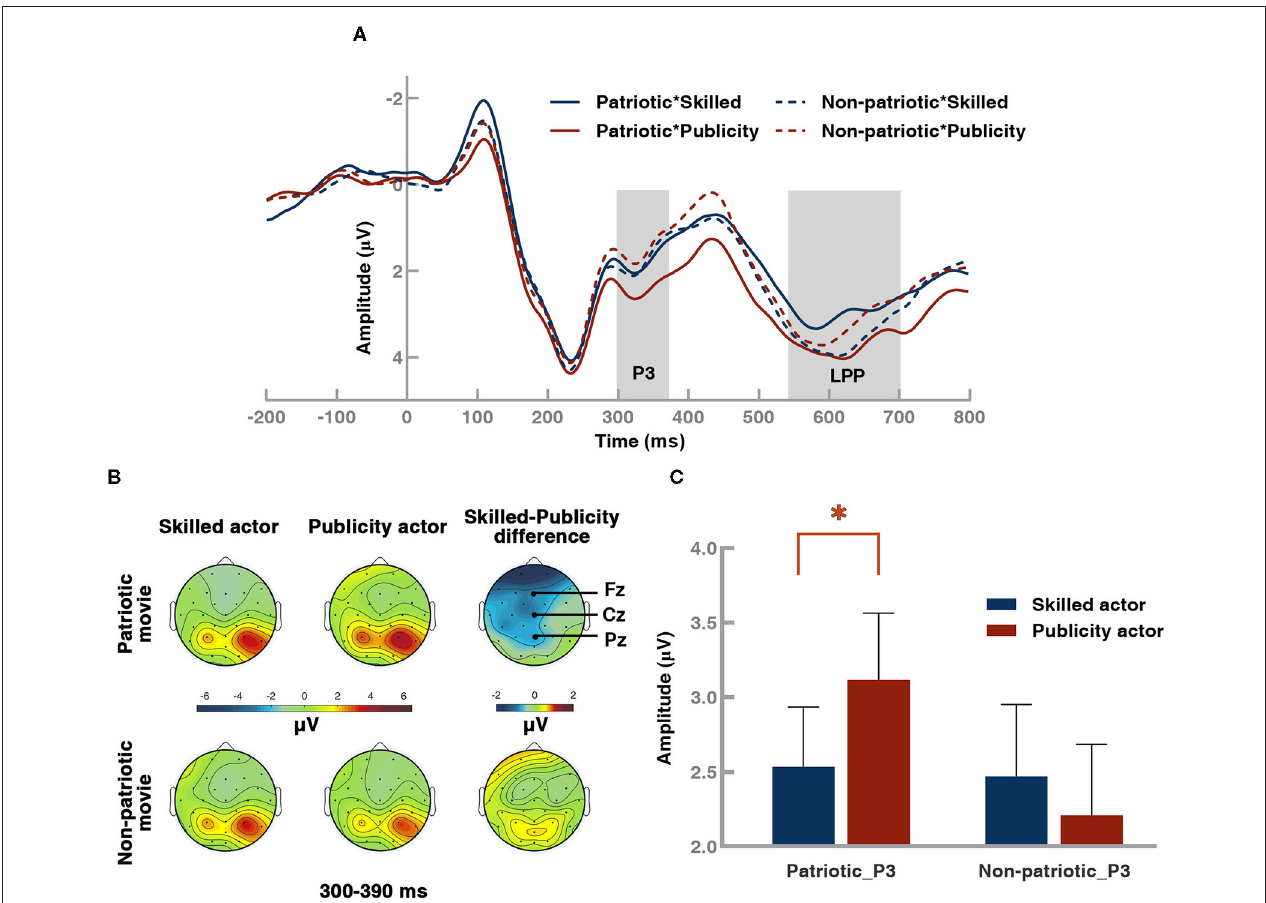
FIGURE 3 | Event-related potential (ERP) waveforms from Pz, topography of grand-averaged P3 waveforms from Pz, and P3 results. (A) Grand-averaged ERP under four conditions: 2 movie types (patriotic: solid line, non-patriotic: dotted line) × 2 actor kinds (skilled: blue, publicity: red). (B) Topography of P3. (C) P3 averaged amplitudes of patriotic movies and non-patriotic movies starring different types of actors from the parietal scalp region. Blue represents the skilled actors, and red represents the publicity actors. The topography was the averaged potential of the 330–390ms time window. Error bar: standard error, * p < 0.05.